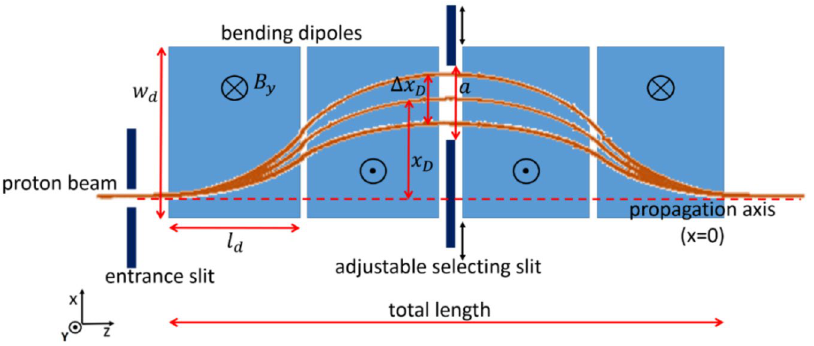
Figure 1. Scheme of the selection device based on conventional magnetic dipoles. The proton beam is bent throughout the magnetic chicane and the particle dispersion reaches its maximum between the second and third dipole. The selecting slit can be adjusted transversely in both position and